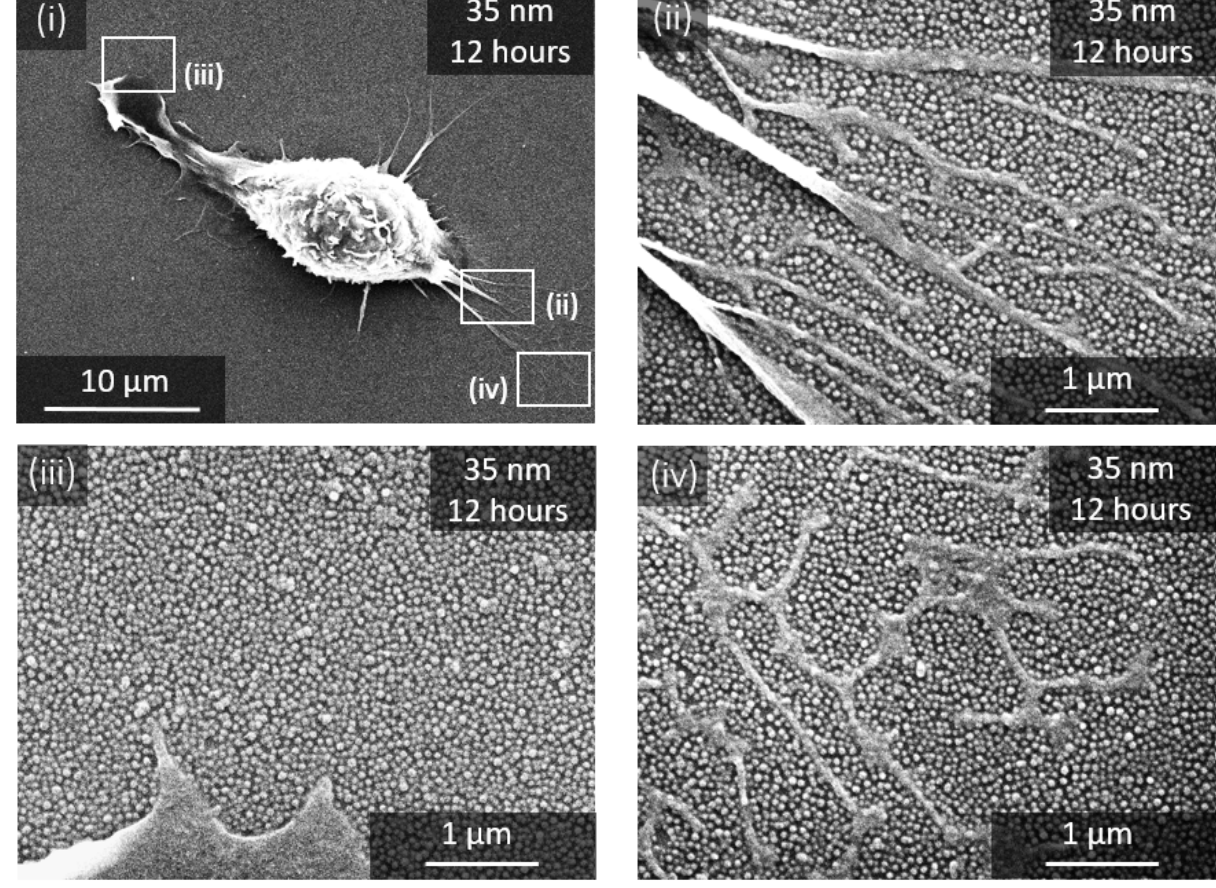
Figure 4. SEM images of macrophages adhering to substrates decorated with 35 nm NPs. After 12 h of incubation ( i ) and at three different spots around the cells at a higher magnification ( ii – iv ).